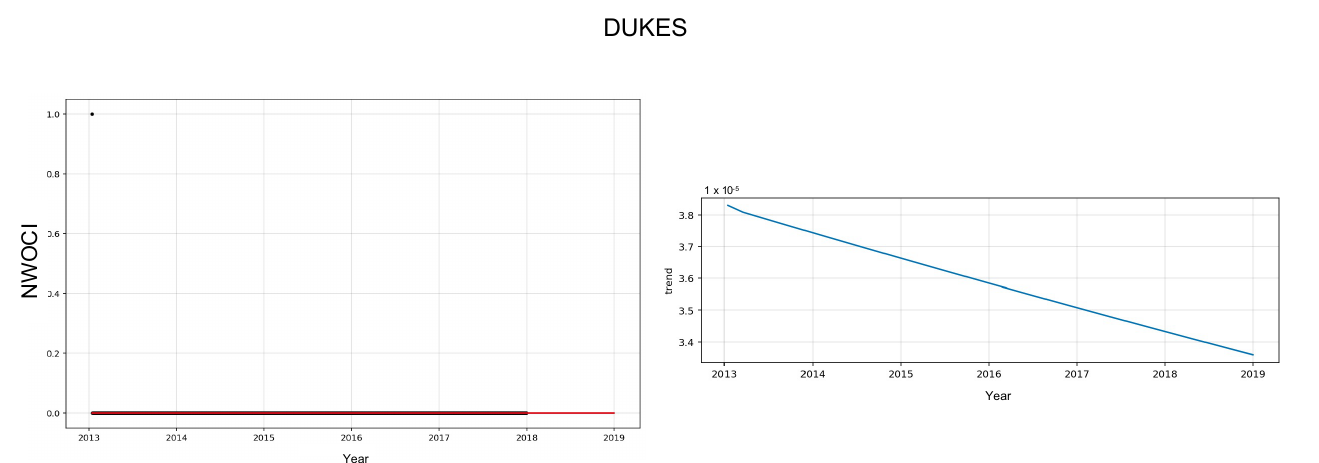
Figure A4. Left : One year forecast (2018 test data) from Prophet-BU Model for Dukes county in MA. N.B: The solid blue line shows the average forecast while the solid red line shows the observed trend of NWOCI and the light blue region represents the 80% confidence interval for the forecast uncertainty. Also, the scatter points represent the historical values in the training data (2013–2017). Right : Trend decomposition from Prophet-BU Model for Dukes county in MA.